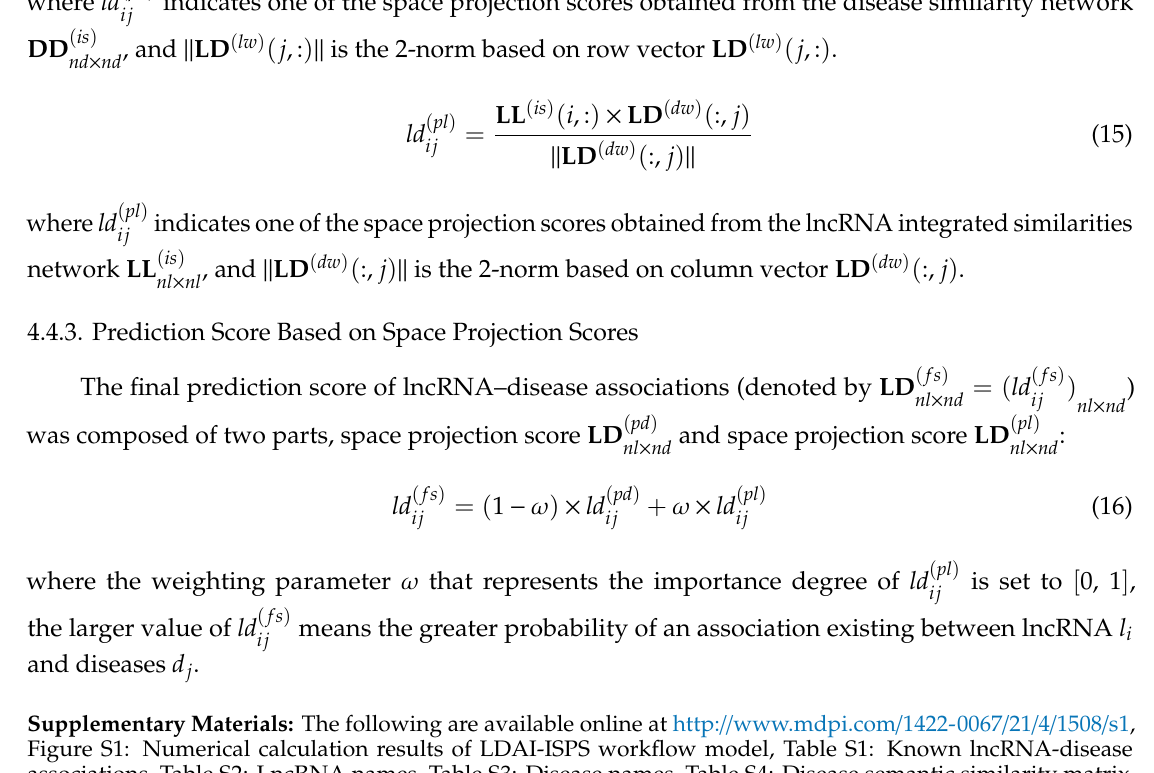
Figure S1: Numerical calculation results of LDAI-ISPS workflow model, Table S1: Known lncRNA-disease associations, Table S2: LncRNA names, Table S3: Disease names, Table S4: Disease semantic similarity matrix, Table S5: LncRNA functional similarity